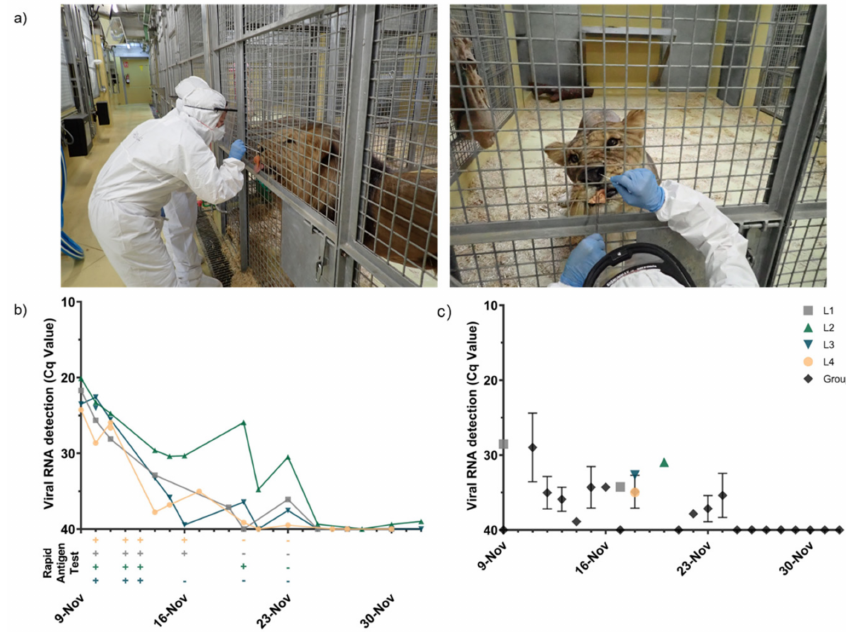
Figure 2. Viral shedding in lions after natural SARS-CoV-2 infection. ( a ) Nasal swab collection procedure in lions. After SARS-CoV-2 infection of the animals was confirmed, trained zoo personnel wore personal protective equipment to access the lion facility and sample the animals using cotton swabs. All four lions were target-trained and were compliant to nasal swabbing by their caretakers. ( b ) Results obtained with a COVID-19 RADT (+, positive; − , negative) and viral RNA levels by RT-qPCR in nasal swab specimens collected from all four lions (L1 to L4). ( c ) SARS-CoV-2 viral RNA levels from individual and collective fecal samples at different time-points after infection. Each colored line/dot represents an individual animal. Black lines/dots indicate collective specimens collected inside the lion facilities. Abbreviations: Cq, quantification cycle; L1, Lion1; L2, Lion2; L3, Lion3; and L4,